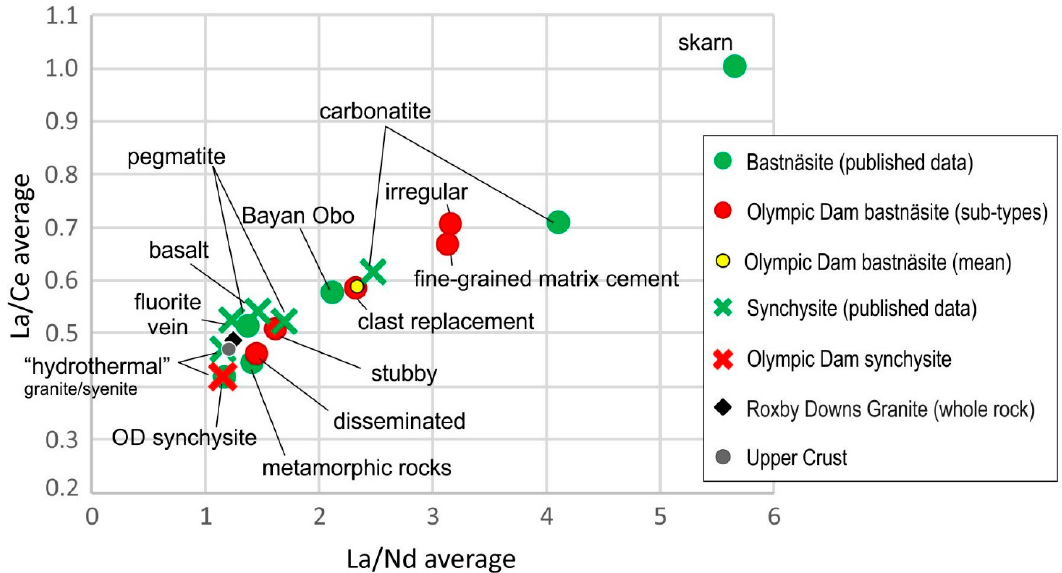
Figure 10. Plot showing mean La/Ce and La/Nd ratios in bastnäsite and synchysite from